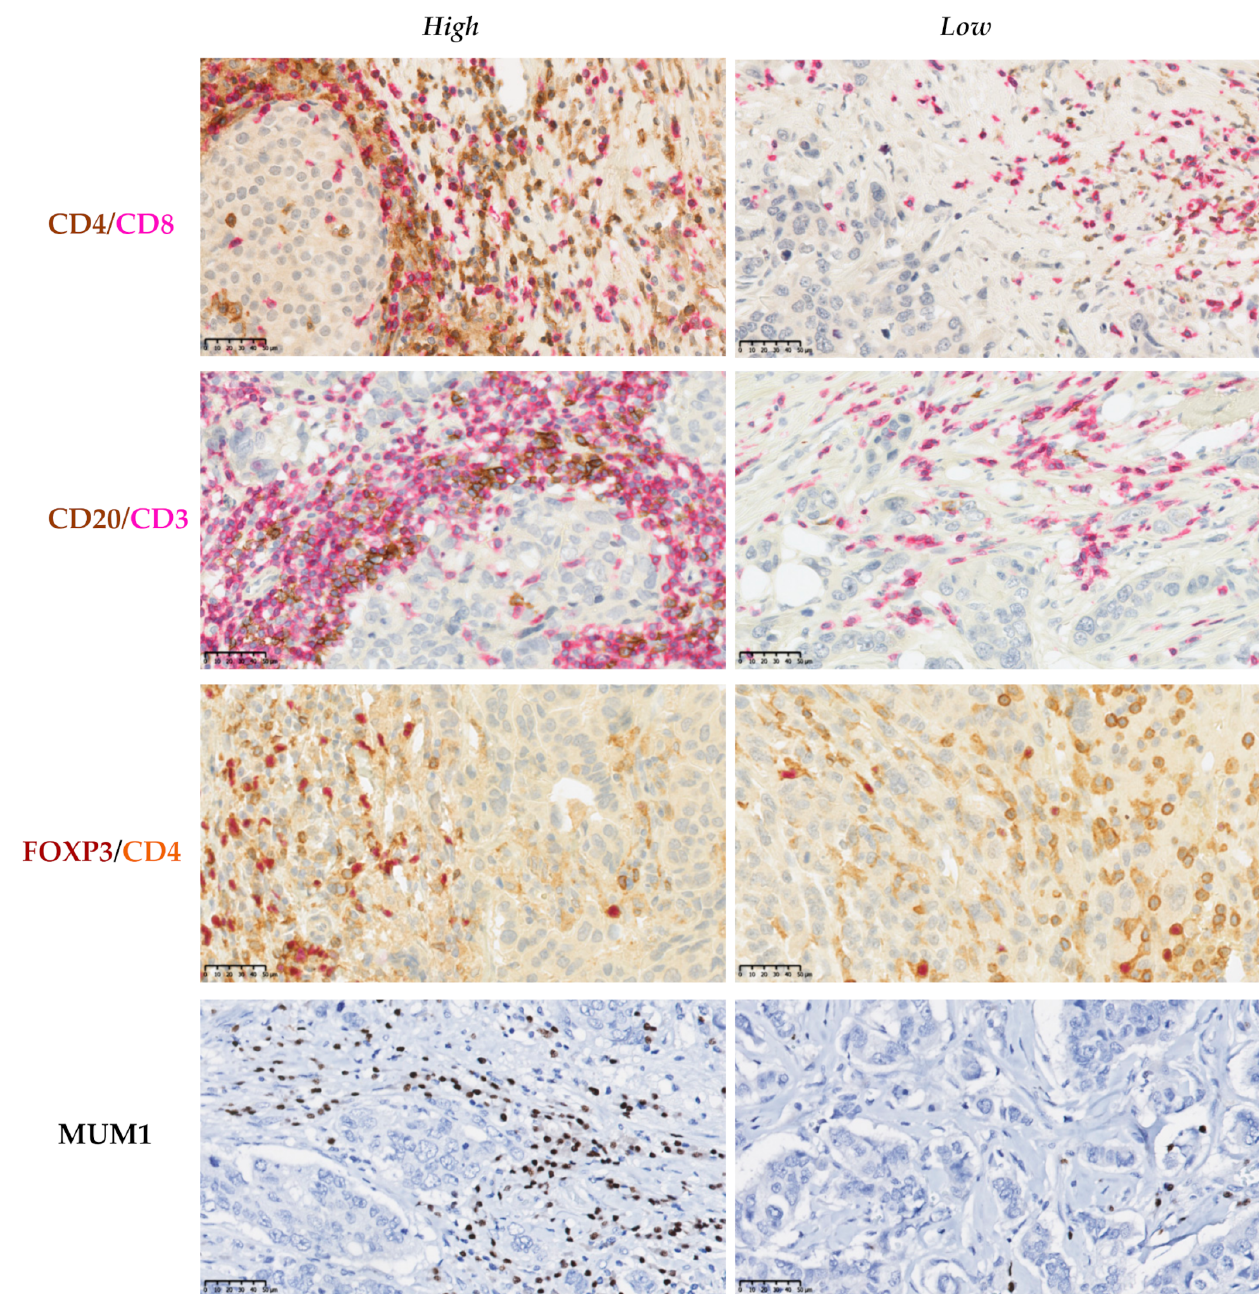
Figure 4. Immunohistochemical assessment of the immune cells in the tumor microenvironment of breast cancer. Double IHC labeling was used to establish the CD4/CD8 , CD20/CD3 , and FOXP3/CD4 ratios. Representative sections showing high and low ratios of these markers. IHC labeling with MUM1 was used to determine the percentage of plasma cells that infiltrate the tumor stroma. Scale bars: 50 µ